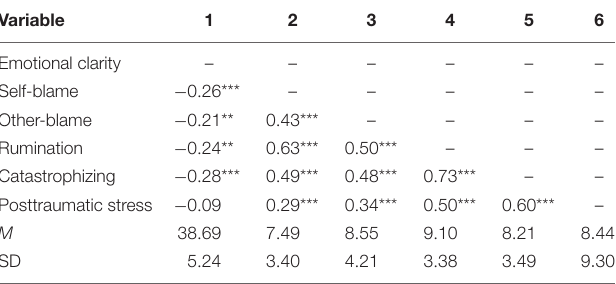
TABLE 2 | Descriptive statistics and correlation coefficients of measured